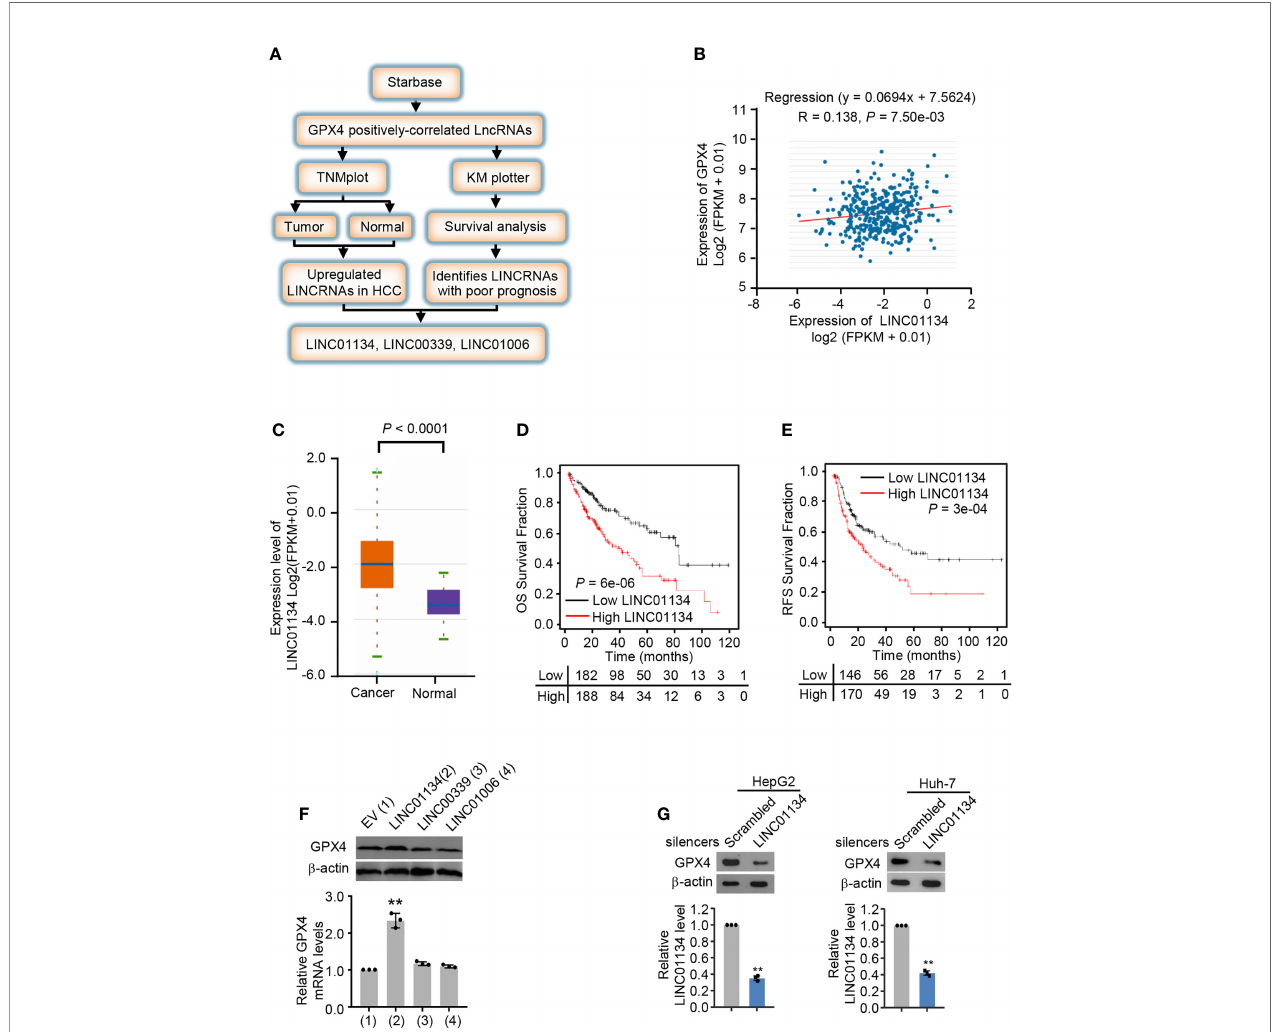
FIGURE 1 | LINC01134 is a novel GPX4 positively correlated LINCRNA and associated with poor clinical prognosis. (A) Schematic diagram of the screening process for identifying up-regulated LINCRNAs in HCC and positively related to GPX4. (B) Pearson ’ s correlation analysis of LINC01134 and GPX4 expression in liver cancer tissues (http://starbase.sysu.edu.cn/). (C) The LINC01134 expression levels between cancer tissues and normal tissues were compared by TNM plot (https:// www.tnmplot.com/). (D, E) Kaplan-Meier analysis of the recurrence-free survival and overall survival rate of HCC patients with high or low LINC01134 expression (http://kmplot.com/analysis/). (F) The mRNA and protein levels of GPX4 in HepG2 cells transfected with empty vector, LINC01134, LINC00339 and LINC01006 expression vectors. (G) The expression levels of GPX4 and LINC01134 in HepG2 (left panel) and Huh-7 (right panel) cells transfected with scrambled and LINC01134 silencers. The data are expressed as mean ± standard error. Data are shown as the mean ± SEM; n ≥ 3 independent experiments, two-tailed Student ’ s t-test: **P <